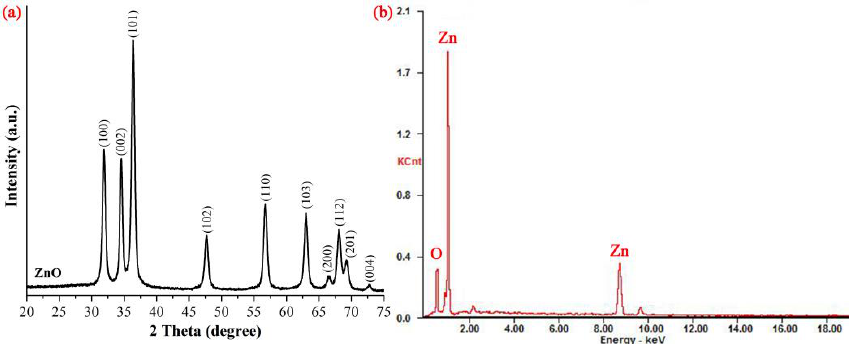
Figure 3. XRD patterns ( a ) and EDS ( b ) of ZnO NPs.